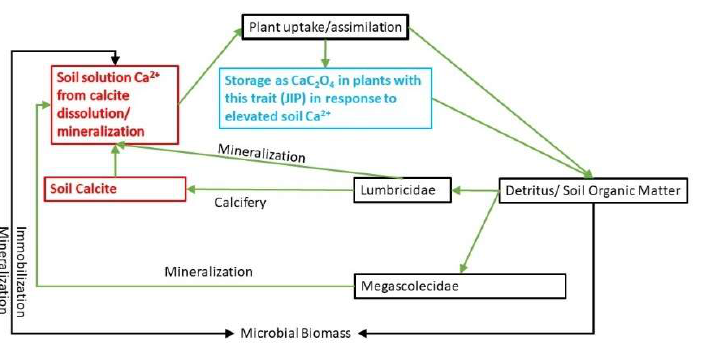
Figure 1. The role of earthworms in the formation of calcium oxalate (CaC 2 O 4 ) formation in ver- miphile plants. Both Megascolecidae and Lumbricidae affect the soil solution Ca 2+ through acceler- ated mineralization rates that are in addition to microbial mineralization. However, Lumbricidae also affects it through calcifery.